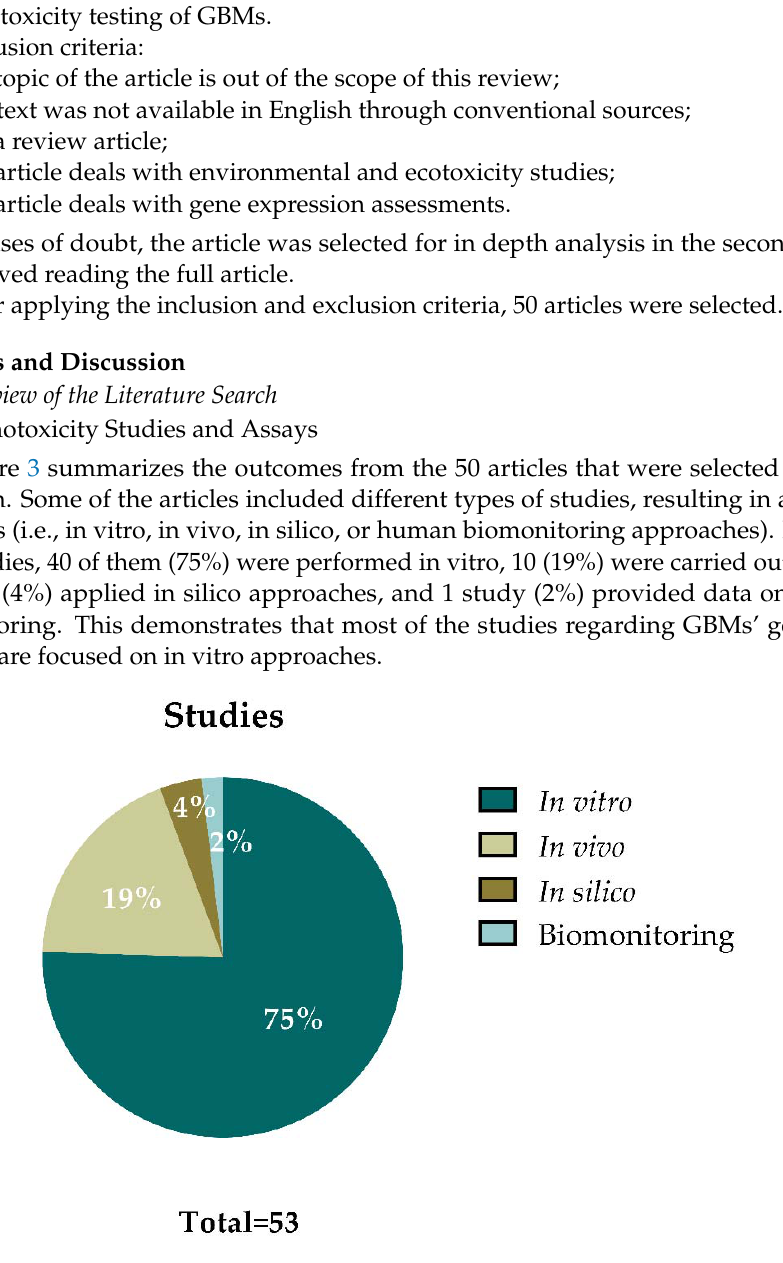
Figure 3. Overview of the 53 genotoxicity studies analyzed in this review. The percentage of each type of study (in vitro, in vivo, in silico, and biomonitoring studies) is indicated inside the different categories represented in the